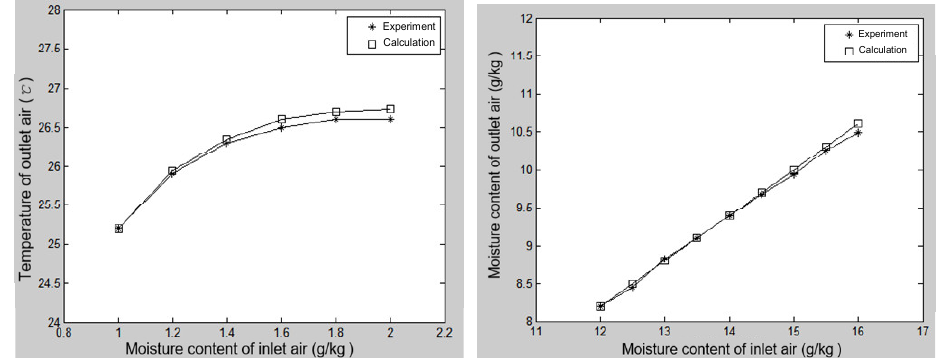
Figure 17. Comparison of calculated and experimental values of moisture content of outlet air.